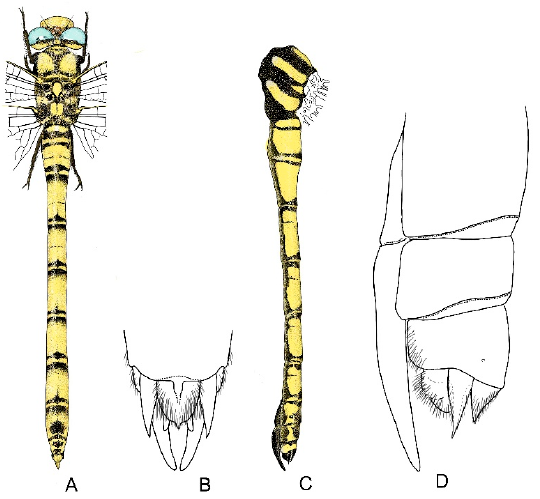
Figure 12. Cordulegaster charpentieri , yellow form ♀ , (RMNH, leg. Elias and Thomas Schneider, RMNH.INS.975674, 06.05.2018, Iran, Lost Paradise, Behesht Gomshodeh, Fars, 30.3339° N, 52.1564° E, 1800 m a.s.l.): ( A ): habitus, dorsal. ( B ): appendages, dorsal. ( C ): habitus, lateral. ( D ): ovipositor, lateral. Individuals from Kerman Province are darker, more similar to typical forms, but much larger and with pterostigma extremely narrow (Figure 13). These individuals are the biggest in the bidentata -group, even bigger than C. heros , and are therefore among the largest dragonflies in the Western Palaearctic. Males from Kerman ( n = 4): TL (including appendages) 81.0–85.0; AL 62.0–65.0; HWL 49.0–55.0. Individuals were found between 1700 and 2200 m a.s.l. Females from Fars are very yellow and are impressive, heavy insects. Females from Fars ( n = 4): TL (including ovipositor) 84.0–88.0; AL: 63.0–7.0; HWL 51.0–57.0.